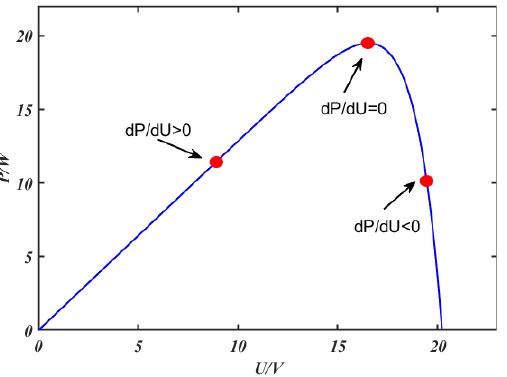
Figure 9. The features of dP/dU variation of P-U characteristics of the photovoltaic cells. When dP/dU = 0, the output power of the photovoltaic cells reaches its maximum value, which can be expressed in (14) as dI/dU = − I / U . The rules for calculating the perturbation step update of the fixed-step conductance increment method are shown in (15). ∆ U = U ( t ) − U ( t − 1); on the left side of the maximum power point, dI / dU > − I / U , the disturbance voltage ∆ U should be increased so as to fasten into the maximum power point as soon as possible. On the right side of the maximum power point, dI / dU < − I / U , the open circuit voltage should be smaller so as to approach the maximum power point.